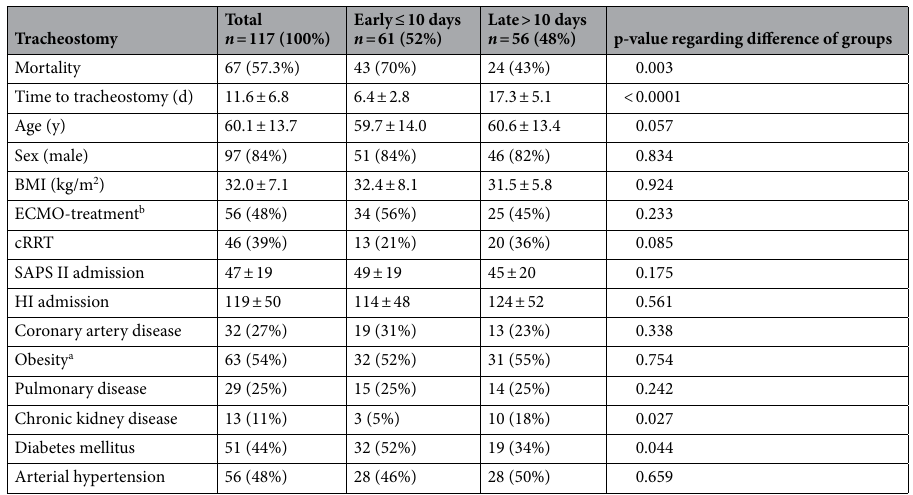
Table 1. Clinical characteristics of CARDS patients with tracheostomy. Data are presented as mean ± standard deviation, count or as patient number [percentage] where applicable. Clinical characteristics of all patients, patients with early (≤ 10 days), patients with late (> 10 days) tracheostomy and corresponding p-value of differences between both time allocations. BMI, Body mass index; d, day; HI, Horovitz index, p a O 2 ·F i O 2 –1 ; kg, kilogram; m, meter; cRRT, continuous renal replacement therapy; SAPS II, Simplified Acute Physiology Score II; y, year. a Defined according to international guidelines as BMI > 35 kg/m 2 . b ECMO was initiated according to the current recommendations of the Extracorporeal Life Support Organization (ELSO). Thus, ECMO was usually initiated before tracheostomy.